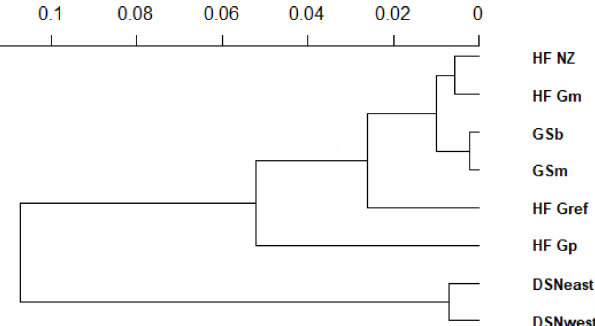
Figure 1. Unrooted dendrogram with bootstrap support using Nei’s standard genetic distances ( D S ) (Nei, 1972). The x axis represents the genetic distances between the eight studied selection lines.